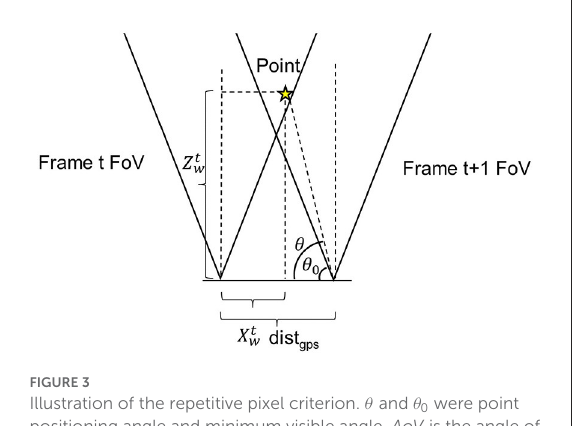
FIGURE3 Illustration of the repetitive pixel criterion. θ and θ 0 were point positioning angle and minimum visible angle. AoV is the angle of view of the camera. x w and z w were point horizontal and in-depth locations in the world coordinate frame. d was the distance between the adjacent frames. The point would have been marked as repetitive in frame t since it falls into the angle of view of camera at frame t +